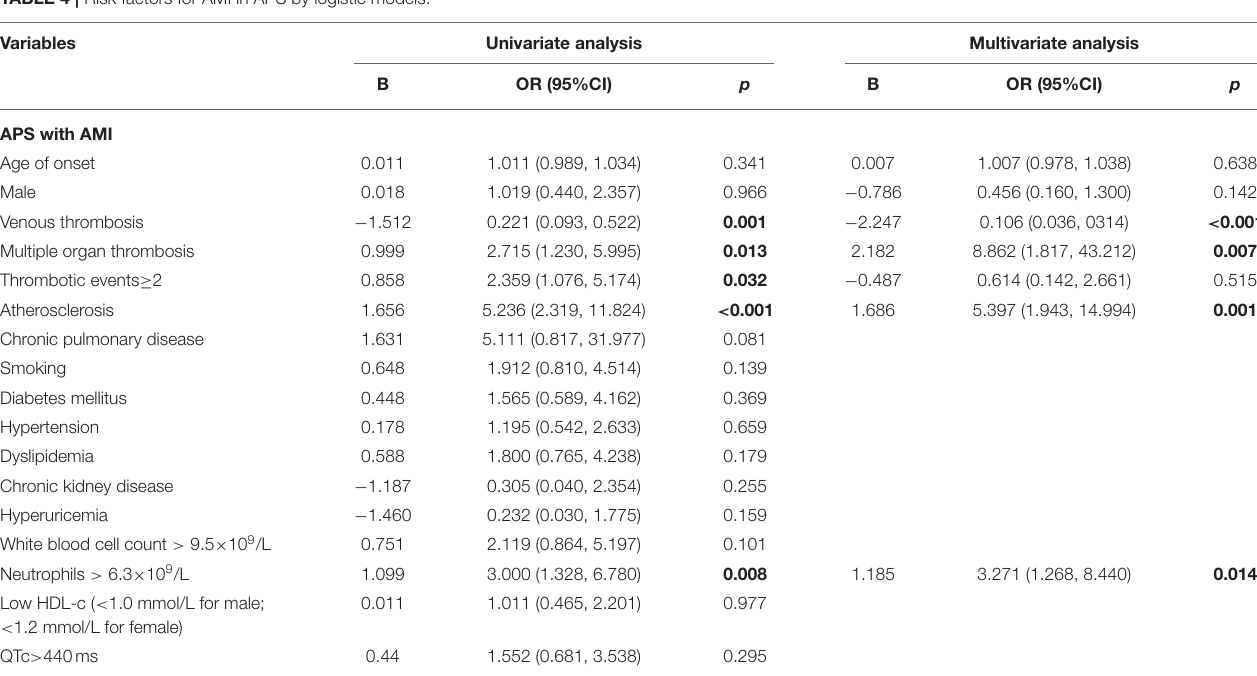
TABLE 4 | Risk factors for AMI in APS by logistic